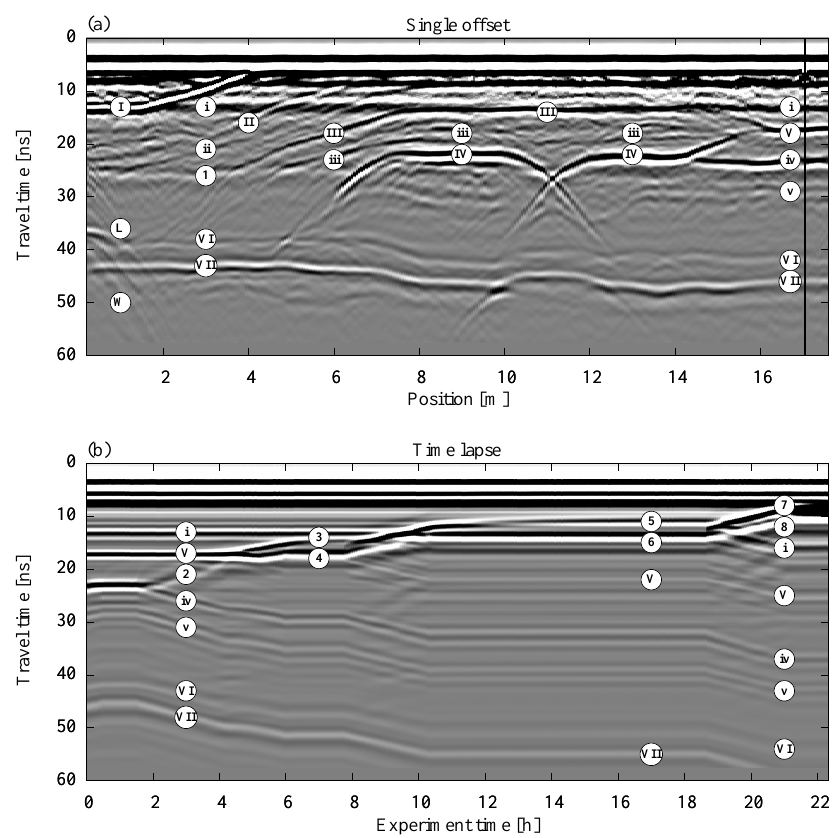
Figure 14. (a) A single-offset measurement of the hydraulic state of ASSESS (Fig. 1) at the beginning of the experiment is shown. For this measurement, the antenna was moved over the site at one point in time. The temporal evolution of the subsequent hydraulic dynamics was monitored with a stationary antenna at the position indicated with the vertical black line. The resulting time-lapse measurement data are shown in (b) . Both radargrams are measured with internal channels with an antenna separation of 0 . 14m. Except for the normalization, the data are processed according to Sect. 2.3. In contrast to the quantitative evaluation, the radargrams are normalized to their maximal absolute amplitude, facilitating the visual comparison of the traces. The markers – uppercase Roman numeral markers for material interfaces (I, II, III, IV, V, VI, and VII), lowercase Roman numeral markers for compaction interfaces (i, ii, iii, iv, and v), and markers with Arabic numerals for reflections originating from the water content distribution – are used consistently in this paper and are further explained in the